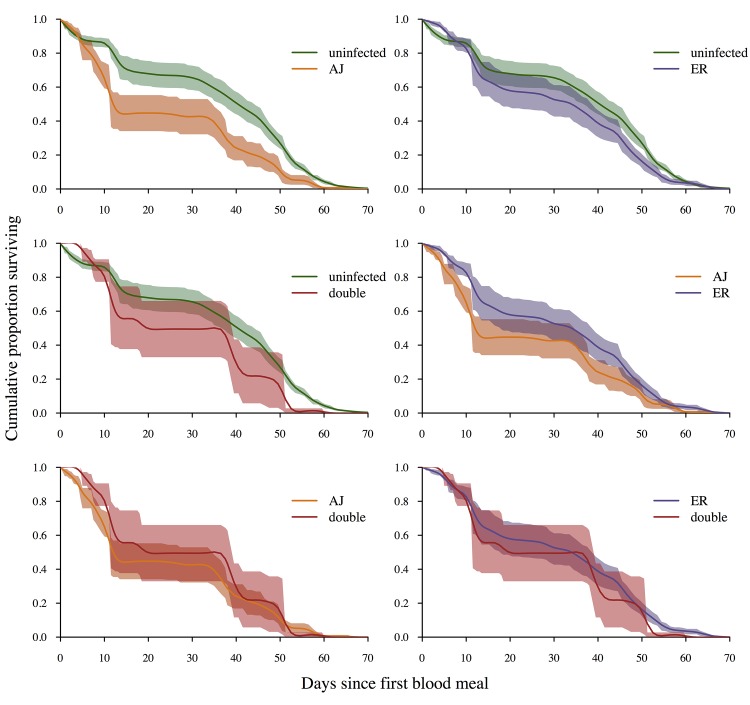
Infection status and vector survival.Survival curves depending on infection status at death (determined by PCR of mosquito cadavers). Lines are a spline fitted to the mean survival curve for mosquitoes with that infection status from between 6 (double infections) and 21 (uninfected) replicate cages. Shaded areas show the standard error of the mean. Mosquitoes infected with AJ had significantly lower survival rates than control mosquitoes (X2 = 5.58, p = 0.02). All other pairwise comparisons were non-significant (p>0.1). For full analysis see results text and Table F in S2 Text.